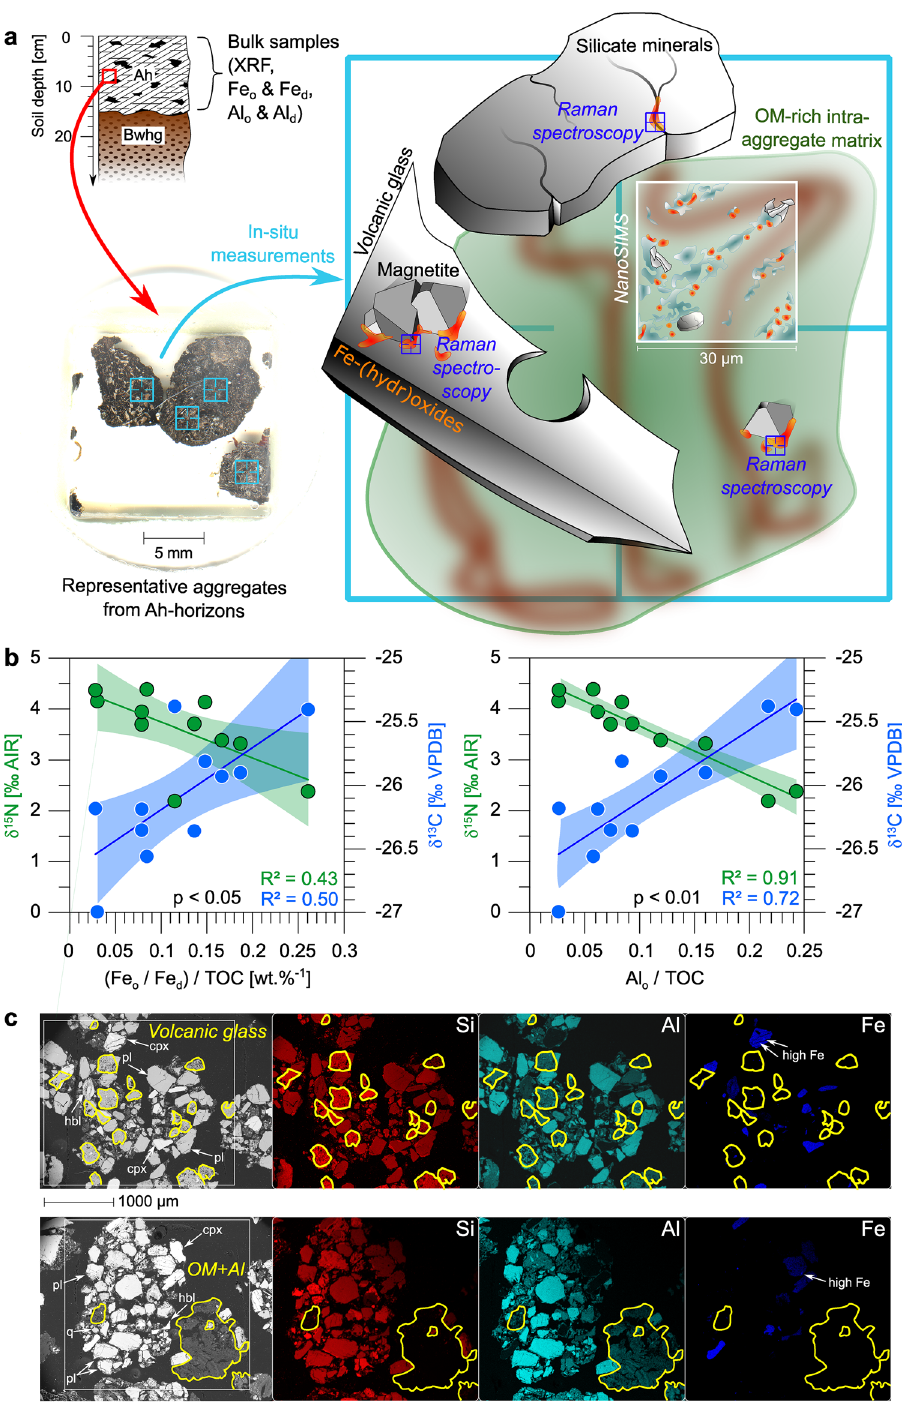
Figure 1. Introduction of the multiple-scale approach combined with the physico-geochemical boundary conditions for (hydr)oxide (trans)formation. ( a) Schematic illustration of the study design encompassing bulk geochemical analyses and in-situ measurements on selected aggregates performed by Raman imaging spectroscopy and NanoSIMS. ( b) (Fe o /Fe d )/TOC and Al o /TOC plotted versus δ 13 C and δ 15 N values from eleven bulk topsoil samples indicate the relationships between Fe-(hydr)oxide crystallinity/amorphous Al-(hydr) oxides and organic matter turnover. Subscripts refer to the treatments used for wet-chemical extraction (citrate bicarbonate dithionite—Fe d , ammonium oxalate—Fe o ; Al o ). Shaded fields represent 95% confidence intervals. ( c ) SEM micrographs showing the distribution of intra-aggregate components and SEM–EDS element mappings of Si, Al and Fe of representative topsoil aggregates. Residual volcanic glass and Al-humus complexes (OM + Al) are highlighted in yellow. Silicate minerals ( q quartz, pl plagioclase, cpx clinopyroxene, hbl hornblende) and Fe-rich inclusions are